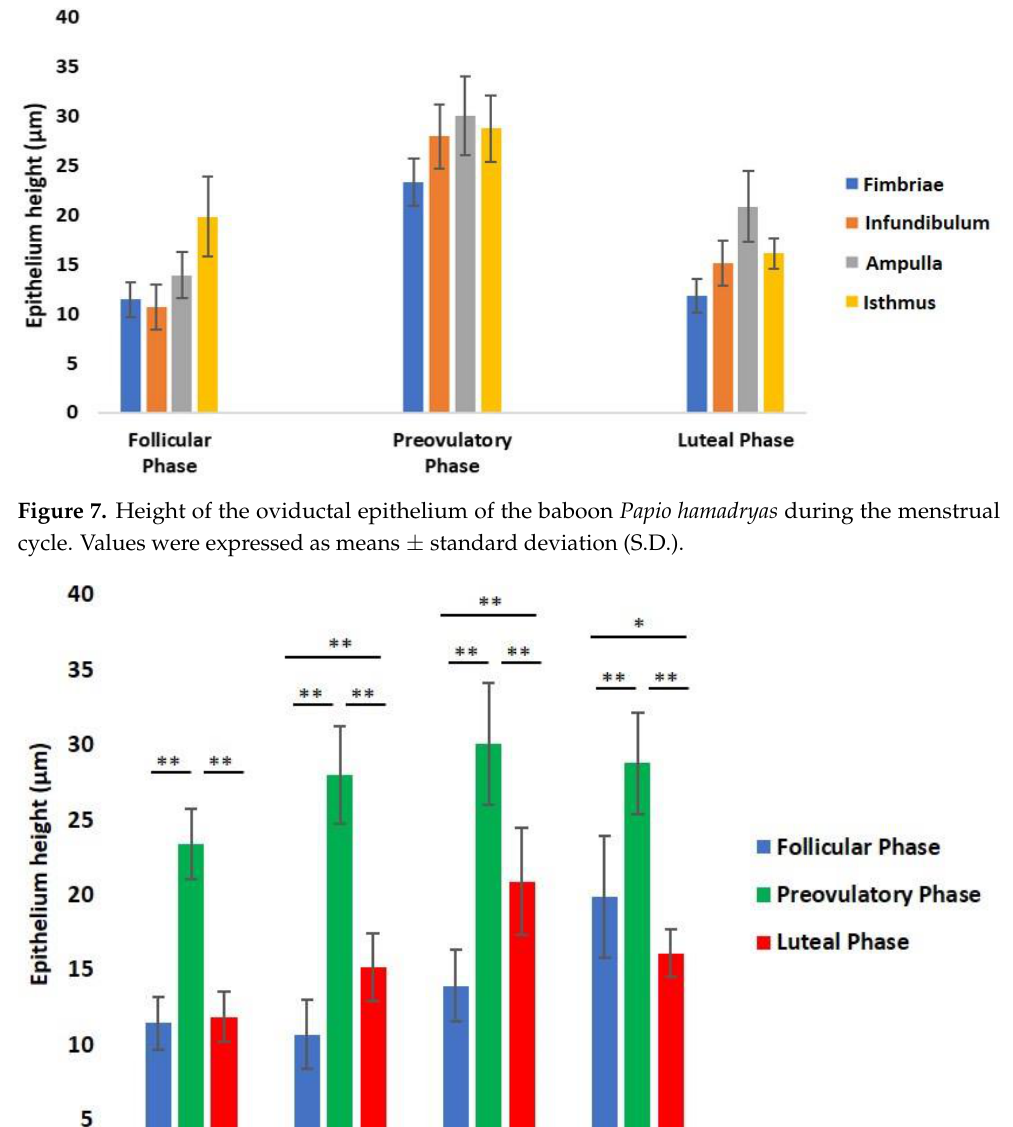
Figure 8. Comparison of the epithelium height of fimbriae, infundibulum ampulla, and isthmus